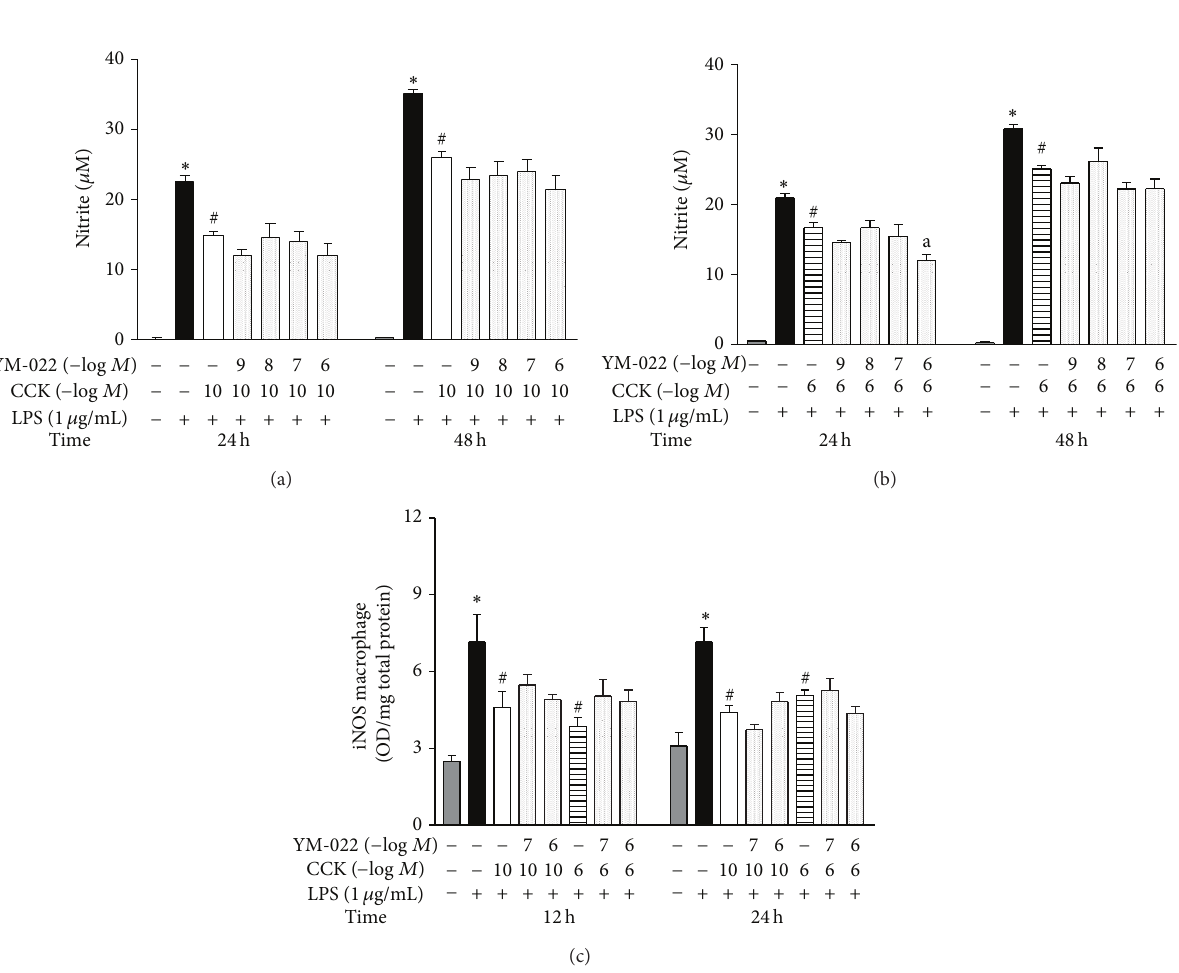
Figure 7: CCK-2R does not alter LPS-induced iNOS expression by peritoneal macrophages. The relevance of CCK-2R was pharmacologically tested, incubating macrophage culture with selective antagonist [YM-022 (CCK-2R antagonist; 10 −9 –10 −6 M)] for 30 min before the addition of CCK at 10 −10 or 10 −6 M. Thirty minutes later, cells were stimulated by LPS (1 𝜇 g/mL) (time zero). At the indicated time-points, the culture supernatant was collected for nitrite quantification by Griess method (a and b), while the iNOS synthesis was determined in cell lysates by ELISA (c). Data is a representative of three independent experiments with similar results. Values are expressed as means ± S.E.M. 𝑛 = 4–12 samples per group. ∗ 𝑃 < 0.05 versus saline, # 𝑃 < 0.05 versus LPS, and 𝑎 𝑃 < 0.05 versus respective CCK